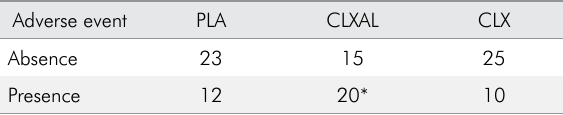
Table 2. Absolute frequency of adverse events during use of the tested solutions (n = 35).